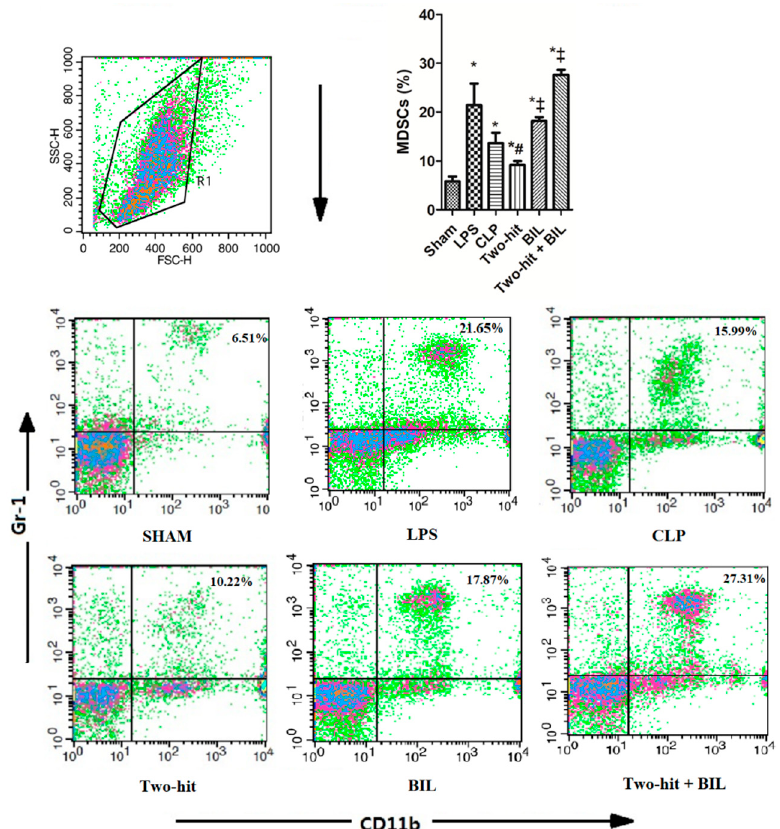
Figure 4. Bilirubin affects the recruitment of MDSC in the blood in the “two-hit” sepsis model. Mice were administered i.p. LPS at 5 mg/kg body weight on day 0. After 24 h, the mice were challenged with cecal ligation and puncture (CLP: 25-gauge needle and double-puncture). Next, the mice were administered bilirubin at 30 mg/kg body weight. The mice were sacrificed 24 h after CLP surgery to collect whole blood, and blood cells were stained to assess the percentages of MDSCs (CD11b + Gr-1 + ). Data are shown as mean ± SD (n = 5 mice per group) and analyzed by one-way ANOVA with Tukey–Krammer multiple comparisons test using the SPSS program. * p < 0.05 versus sham. # p < 0.05 versus LPS. ‡ p < 0.05 versus “two-hit”.